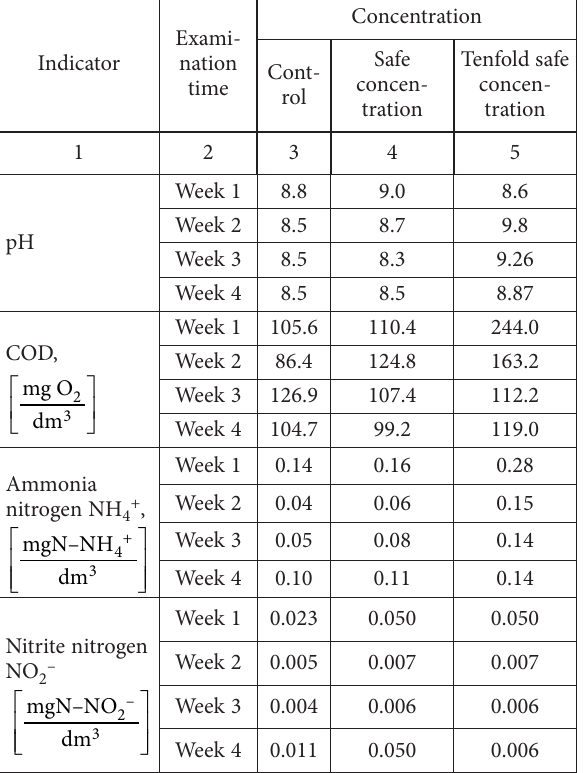
Table 2. Chemical parameters in microcosm study